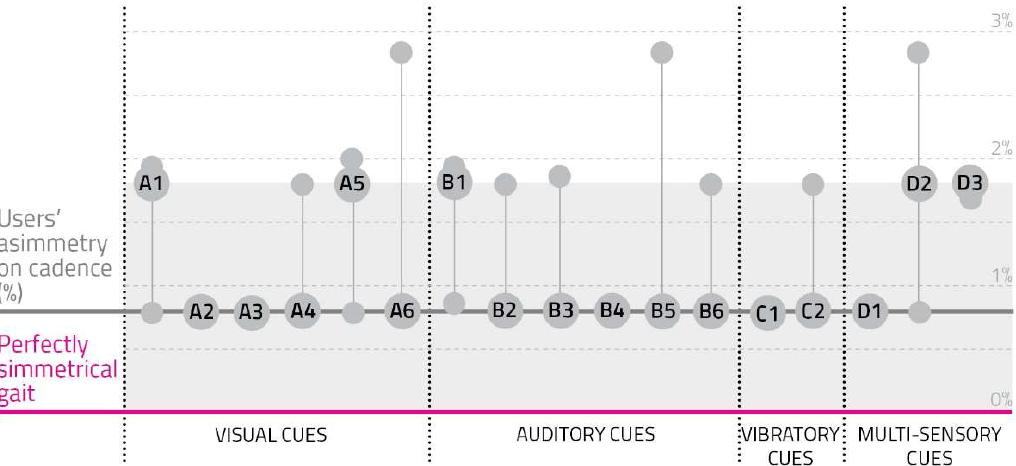
Figure 7. Users’ asymmetry in right and left cadence variability. The gray section represents the user’s typical asymmetry of cadence, while the pink line is a perfectly symmetrical gait. Every cue prototype corresponds to the vertical line connecting three circles: the one on the lower part of the line represents the user with the lower asymmetry on cadence; the second circle is bigger and shows the cue code, standing for the average user’s asymmetry in right and left cadence variability; the upper small circle indicates the user with the most asymmetrical gait